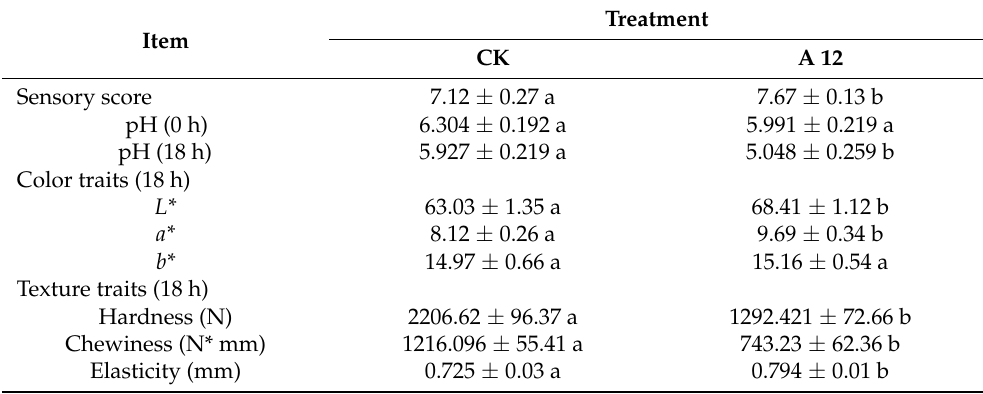
Table 3. Sensory, colour, and texture traits of fermented sausage in different treatment groups.